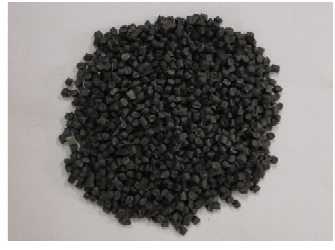
Figure 2. Anti-rut agent. Table 3. Properties of the anti-rut agent.